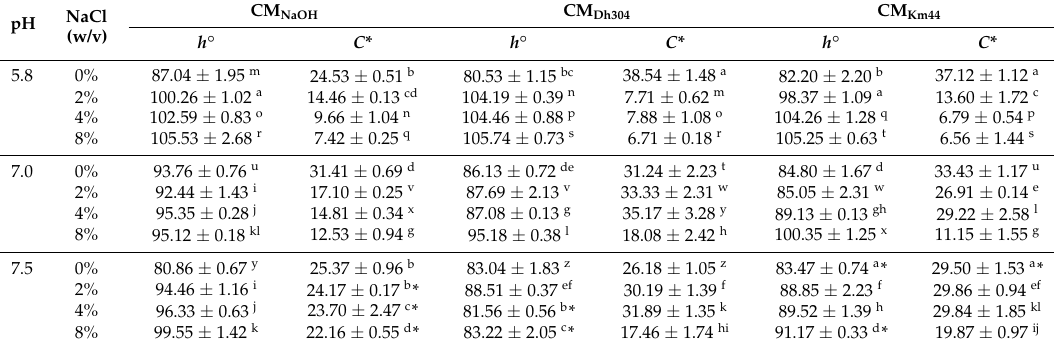
Table 1. The h ◦ values and the saturation ( C *) of Arthrobacter arilaitensis Po102 cultures on cheese curd-based solid media deacidified by NaOH (CM NaOH ), Debaryomyces hansenii 304 (CM Dh304 ),